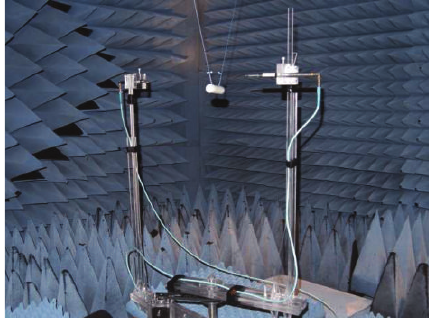
Figure 1: Experimental setup. The TX is on the left, the RX is on the right, and a target is visible in the top center, hanging from the